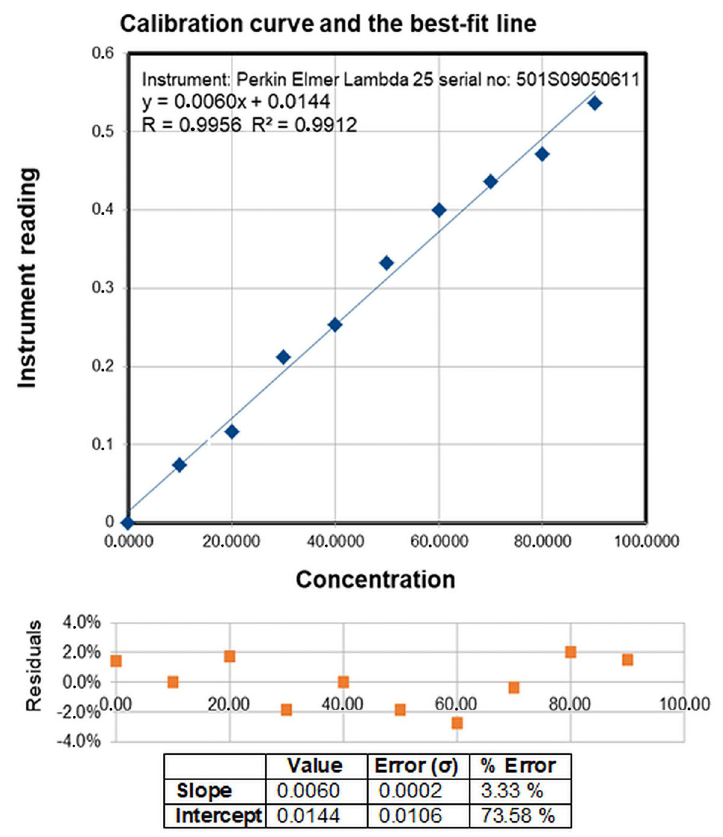
Figure 1. Calibration curve for total protein content in the venom.